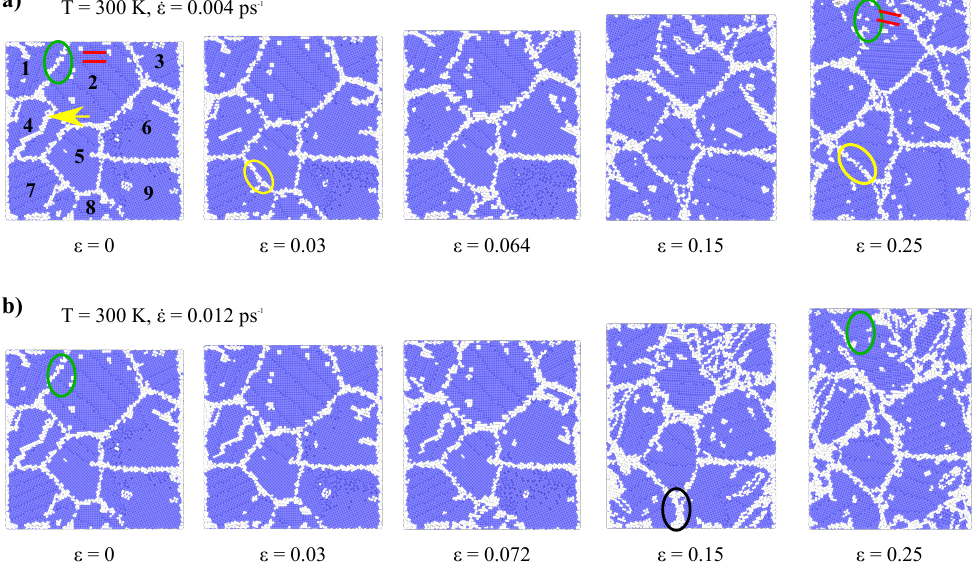
Figure 2. Deformation snapshots of the specimen show the progress in tensile loading at constant temperature and different strain rates.